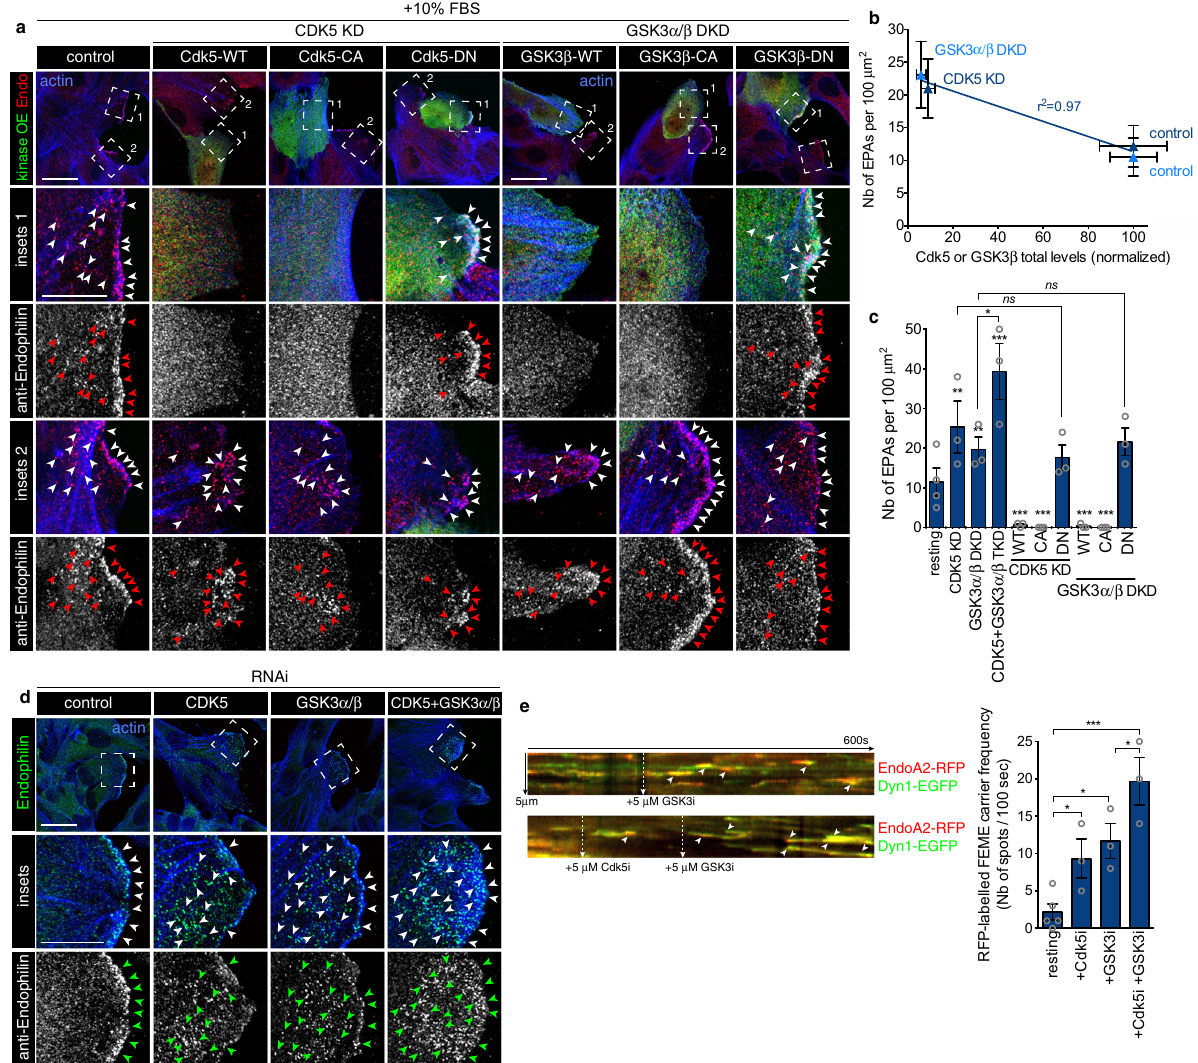
Fig. 3 Cdk5 and GSK3 β act in synergy to control FEME. a Confocal microscopy images of control RPE1 cells (control), or cells in which Cdk5 or GSK3 α and β had been knocked-down using RNAi (CDK5 KD or GSK3 α / β DKD, respectively) cells. Wild-type (WT), constitutively active (CA) or dominant negative (DN) forms of Cdk5 or GSK3 β (green) were overexpressed in a knock-down background and endogenous Endophilin (red) was immunostained, as indicated. All cells were stimulated with + 10% FBS (20% fi nal) for 10 min prior to fi xation. Arrowheads point at FEME carriers. Scale bars, 20 μ m. b Correlation between the number of EPAs and their Cdk5 or GSK3 β levels (single cell measurements) in control, Cdk5 or GSK3 α / β depleted cells, as indicated. Plots show the mean ± SEM from fi ve cells per condition from three independent biological experiments. Linear regression fi t is indicated as r 2 value. c Number of EPAs in RPE1 cells treated as indicated in a and d . Histograms show the mean ± SEM from three independent biological experiments ( n = 50 per condition). Statistical analysis was performed by one-way ANOVA. ns , non signi fi cant; * P < 0.05, ** P < 0.01, *** P < 0.001. d Confocal microscopy images of resting control RPE1 cells (control), Cdk5 (CDK5 KD), GSK3 α and β (GSK3 α / β DKD) or Cdk5 and GSK3 α / β (Cdk5 + GSK3 α / β TKD) knocked-down cells. Arrowheads point at FEME carriers. Scale bar, 20 μ m (main) and 10 μ m (inset). e Kymographs from cells expressing low levels of Dynamin1-EGFP and EndophilinA2-RFP, treated with CHIR-99021 (GSK3i) or Dinaciclib (Cdk5i) as indicated and imaged at 2 Hz. Arrowheads point at FEME carriers. Kymographs are representative of at least three captures from biological triplicates. Histograms show the mean ± SEM from three independent biological experiments ( n = 3 cells per condition). Statistical analysis was performed by one-way ANOVA. * P < 0.05, *** P < 0.001. depletion of the endogenous kinases (Fig. 3a, c). The dual inhi- GSK3 α / β increased spontaneous FEME in resting cells (Fig. 3a, b bition of Cdk5 and GSK3 β occasioned a synergistic activation of and Suppl. Fig. 2b), and, conversely, in individual cells, the FEME (Figs. 1d and 3d, e), driving not only cargo loading but also expression levels of the kinases correlated negatively with FEME FEME carrier budding and lateral movement within the activity ( r 2 = 0.97, Fig. 3b). This con fi rmed the data obtained with the kinase inhibitors, but also suggests that as long as the kinases cytoplasm. are inactive, FEME is elevated, as gene depletion by RNAi persists for several days. RNAi rescue with high levels of either wild type Cdk5 and GSK3 β regulate dynamin recruitment onto FEME (WT) or constitutively active (CA) forms of the kinases were carriers . Dynamin mediates the budding of FEME carriers 5 and is suf fi cient to suppress FEME. However, dominant-negative forms known to be phosphorylated on Ser778 by Cdk5 20 , and (DN) of either Cdk5 or GSK3 β did not rescue the effect of the NATURE COMMUNICATIONS| (2021) 12:2424